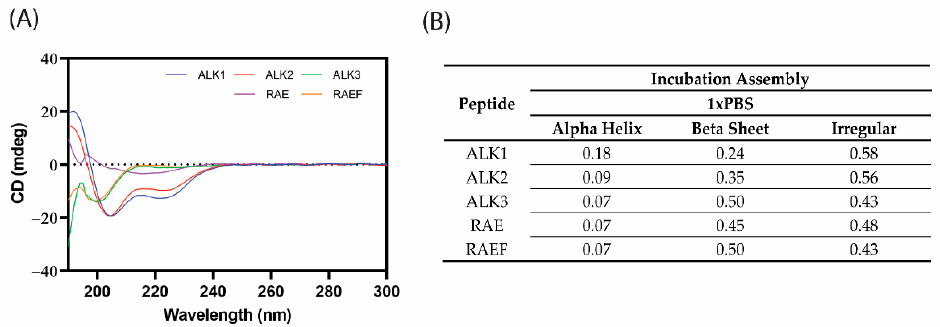
Figure 5. Peptides were assembled through incubation in PBS. Circular dichroism spectra were recorded from 190–300 nm ( A ). Spectra were analyzed on DichroWeb [22,23] using the K2D method to estimate secondary structure ( B ).